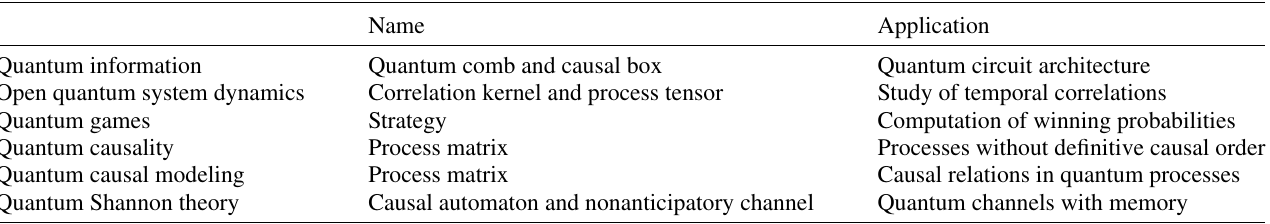
TABLE I. “Process tensors” in different fields of quantum mechanics. Mathematical objects that are similar in spirit to the process tensor crop up frequently in quantum mechanics. The below table is an incomplete list of the respective fields and commonly used names. Note that, even within these fields, the respective names and concrete applications differ. Additionally, some of the objects that occur on this list might have slightly different properties than the process tensor (for example, process matrices do not have to display a global causal order), and might look very different than the process tensor (for example, it is a priori not obvious that the correlation kernels used in open quantum system dynamics are indeed variants of process tensors in disguise). These disparities notwithstanding, the objects in the table are close both in spirit, as well as the related mathematical